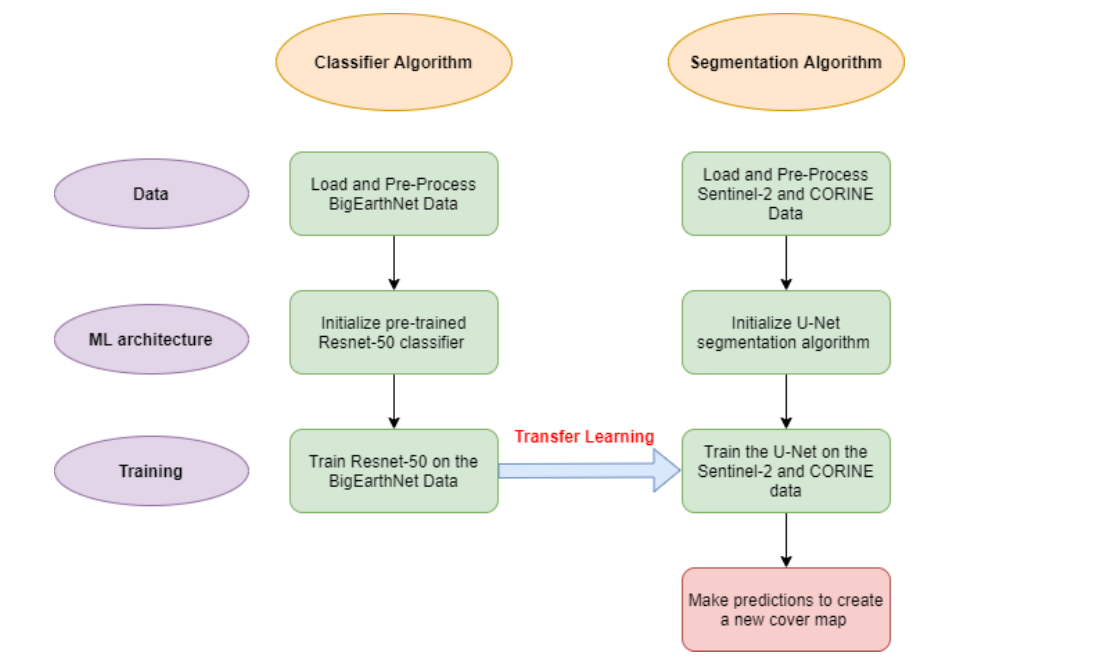
Figure 2. Flowchart of the full workflow of the segmentation